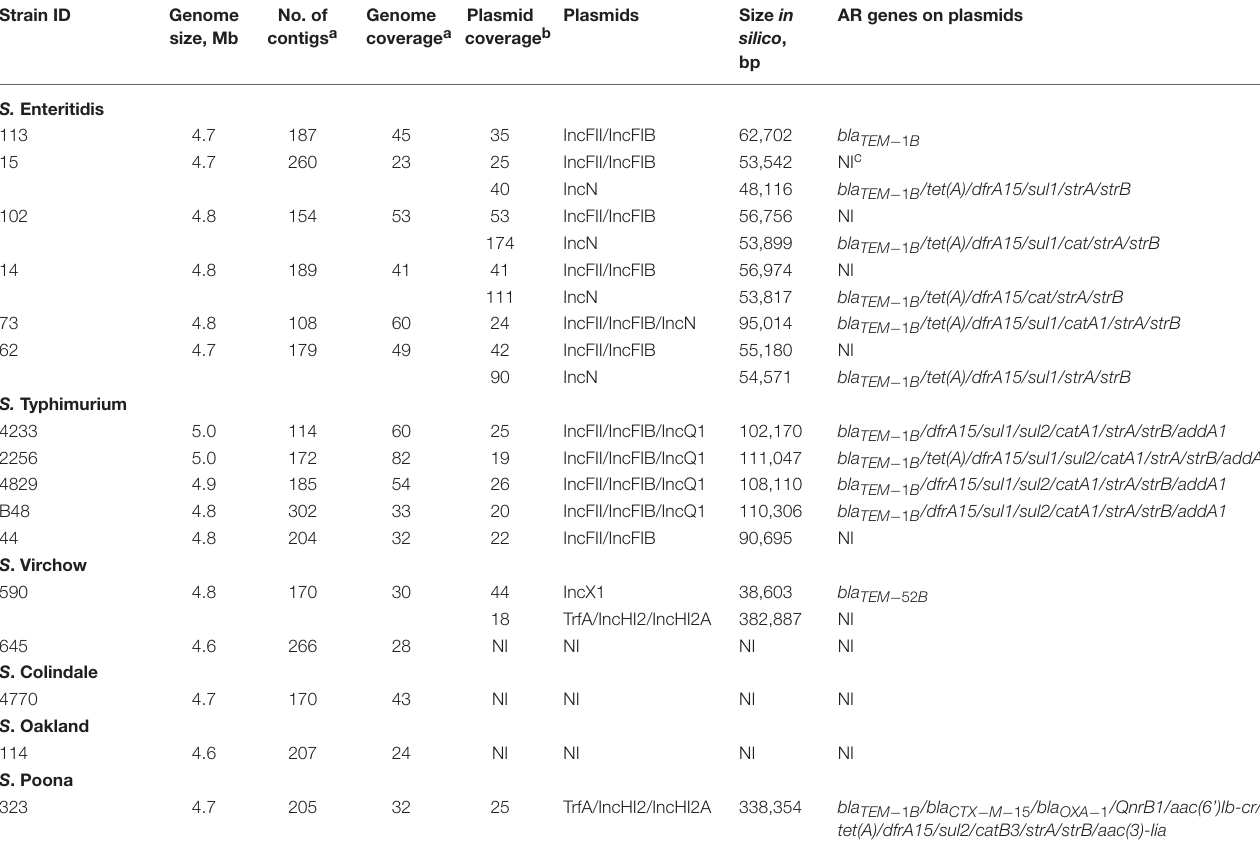
TABLE 3 | Genome assembly characteristics of Salmonella enterica serovars, resistance plasmids and resistance genes identified. Strain